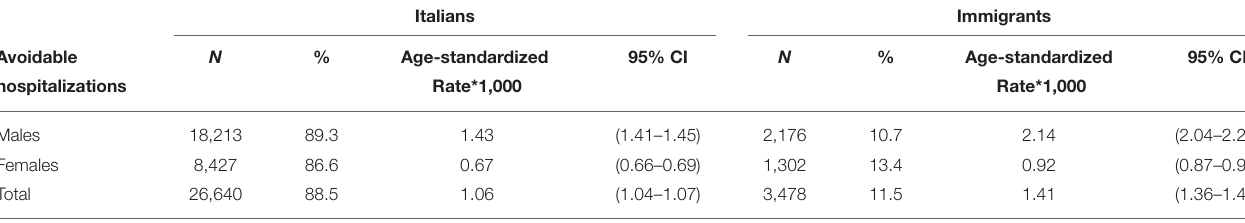
TABLE 2 | Avoidable hospitalizations: proportions and age-standardized rates per 1,000 residents, by sex and citizenship (20–64 years). Italians Immigrants